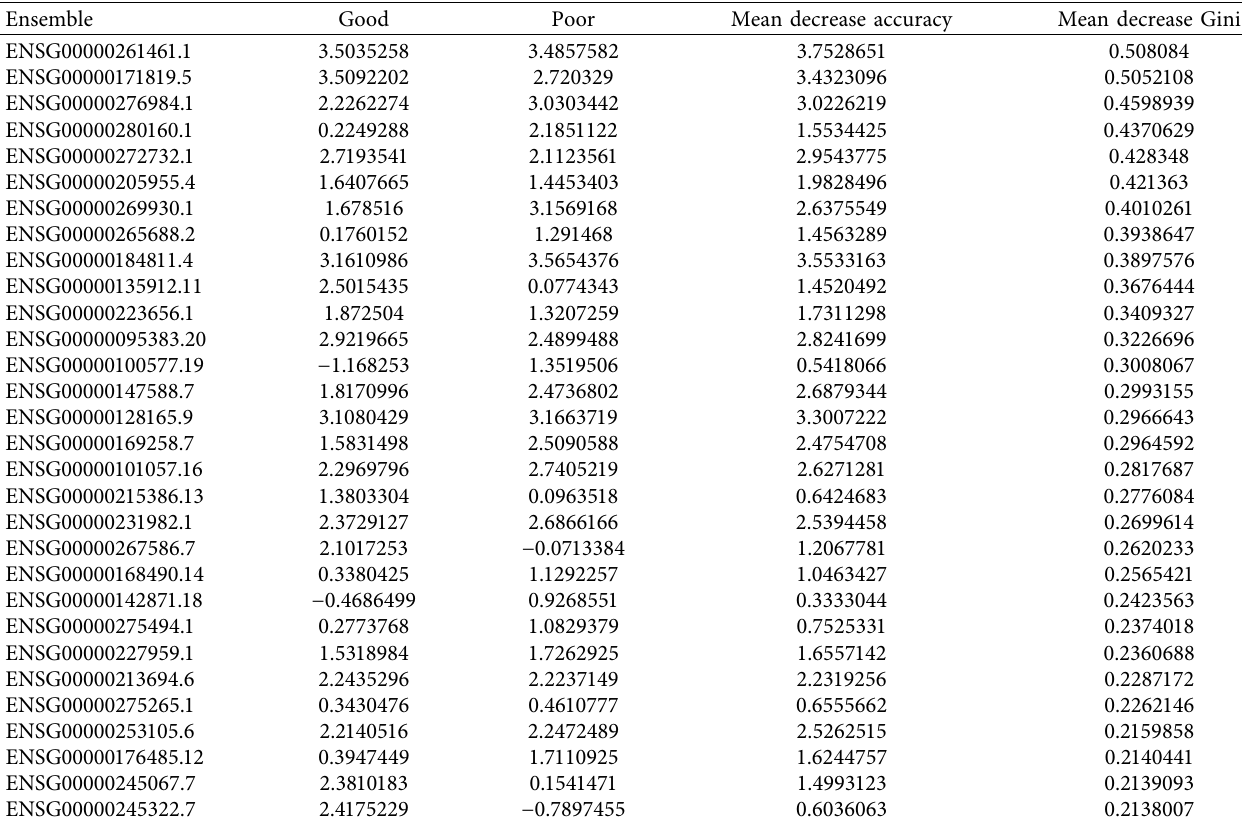
Table 1: 30 important genes screened by random forest.